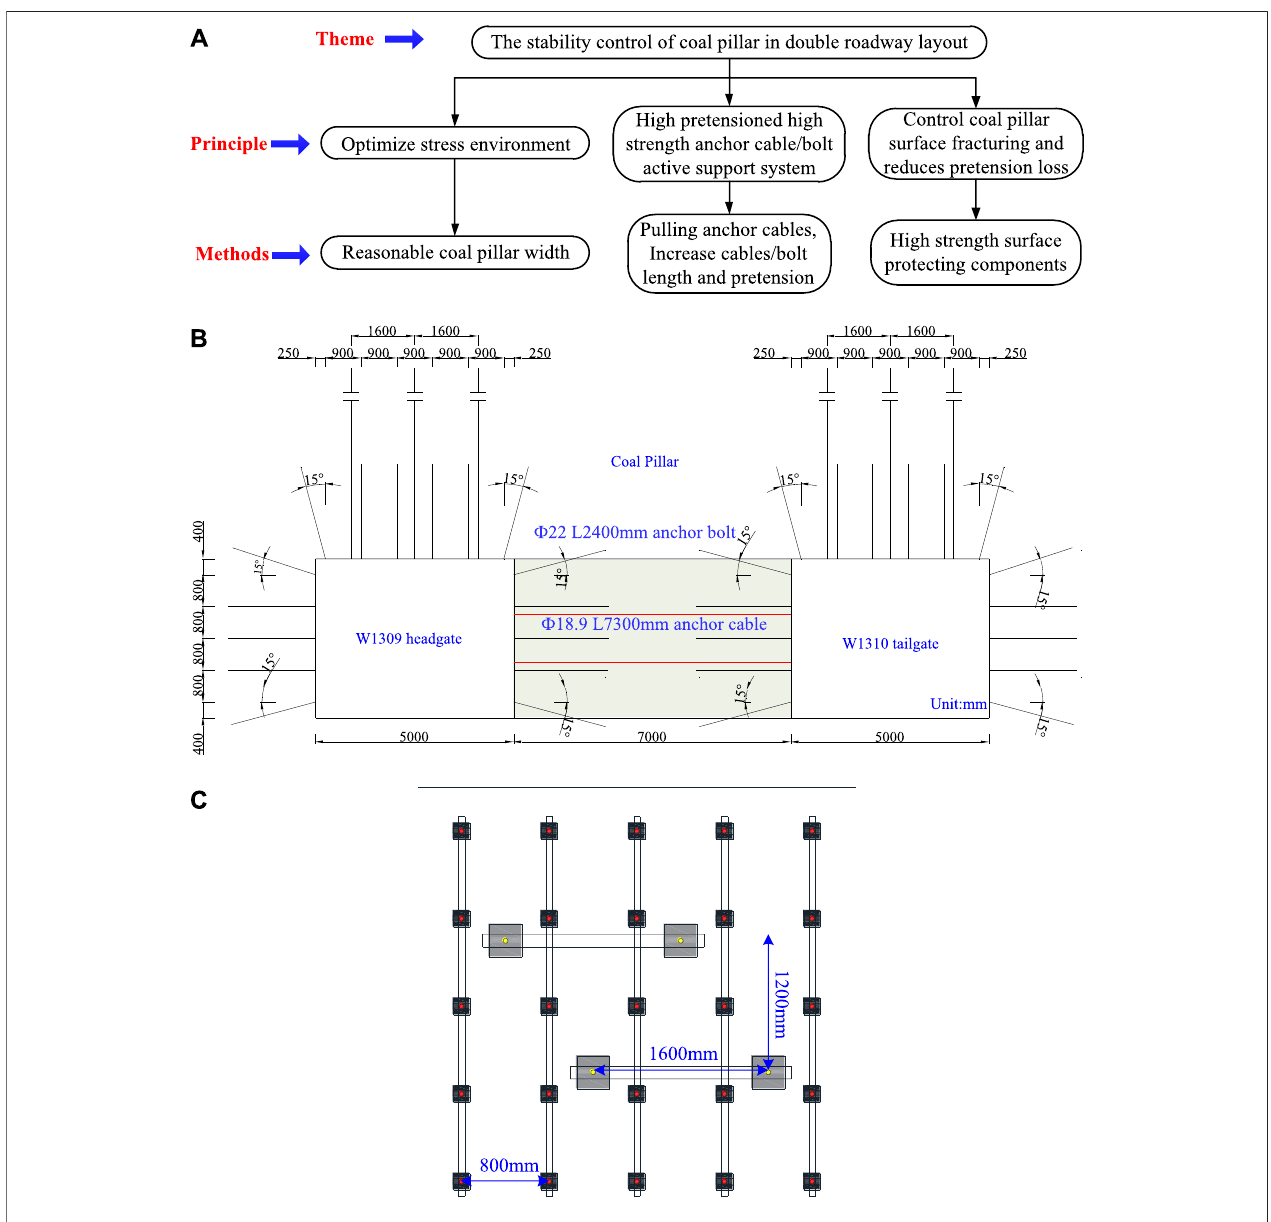
FIGURE12| W1310 tailgateand thecoalpillar supportparameters. (A) Logicrelation diagram ofcoal pillarstability controlofdouble roadway layout; (B) Themain view of the double roadway layout system support parameters; (C) The side view of the supporting parameters of coal pillar.